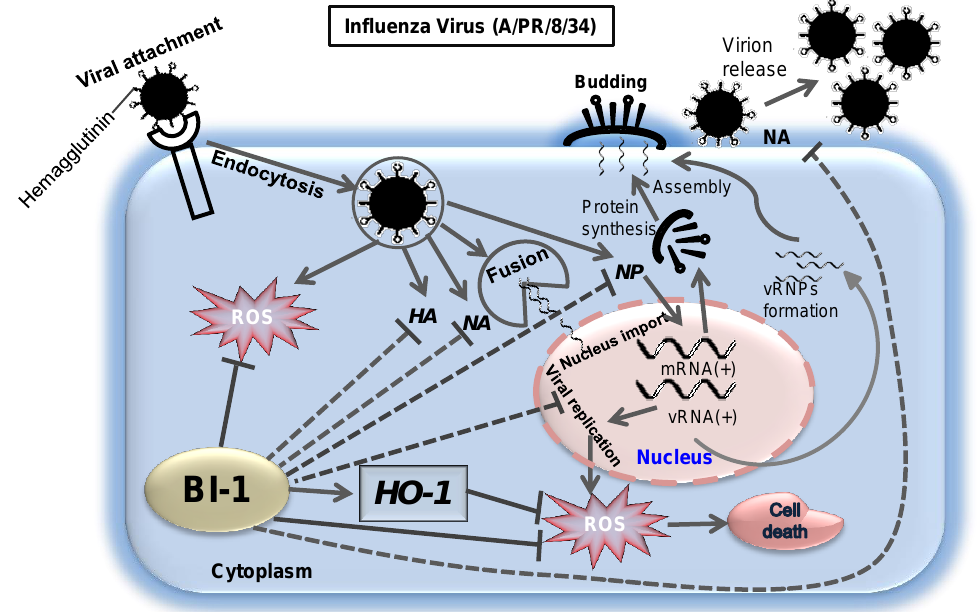
Figure 6. Mechanism of action of Bax inhibitor-1 to protect MDCK cells from influenza virus infection-induced ROS production and cell death. After attachment to the host cell, the influenza virus induces viral replication and ROS production in the host cells. BI-1 overexpression in influenza virus-infected cells enhances HO-1 expression and suppresses ROS production, accompanied by a reduction in viral replication and propagation. BI-1 may inhibit the new virion assembly and release from the infected cells by inhibiting function of viral genes including HA , NA , and NP . (Abbreviations: hemagglutinin ( HA ), neuraminidase ( NA ), nucleoprotein ( NP ), viral ribonucleoproteins (vRNPs), and heme oxygenase-1 ( HO-1